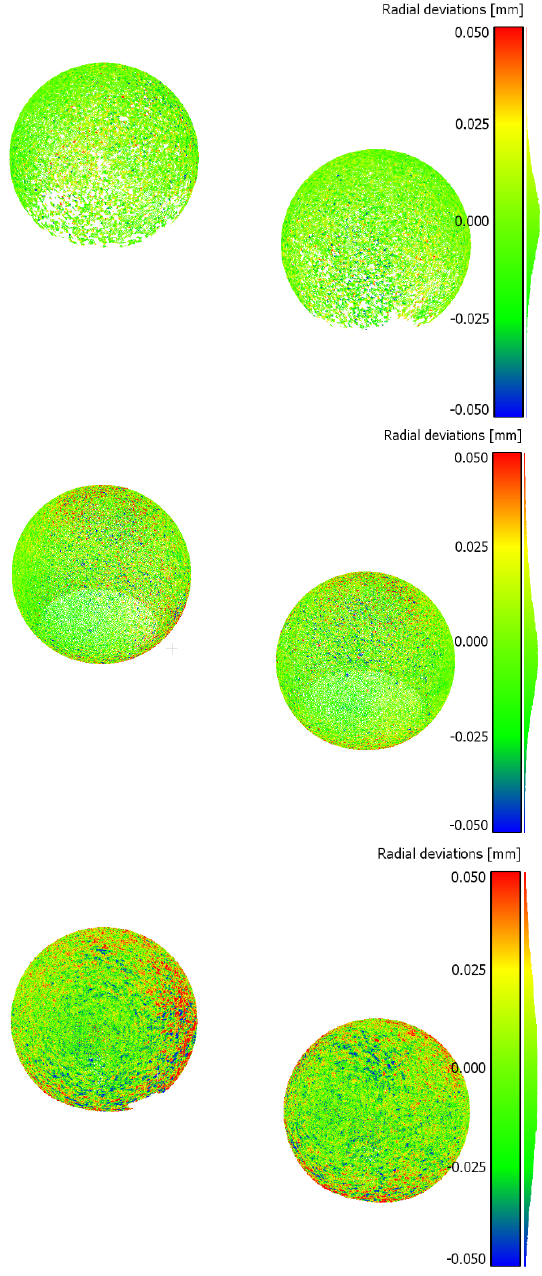
Figure 6. Radial deviations of SmartScan (top), SURE (middle) and Metashape (bottom)